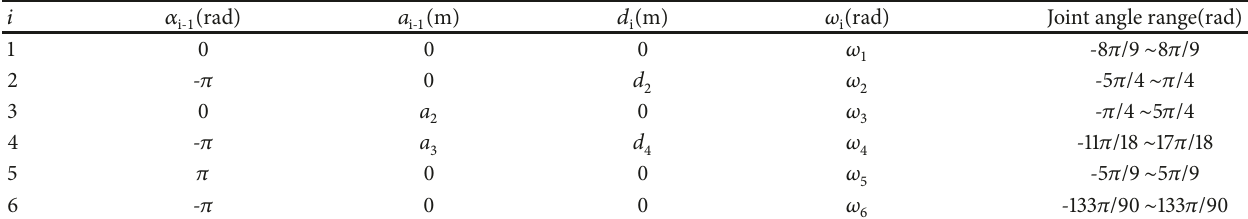
Table 1: Connecting rod parameters of PUMA560.